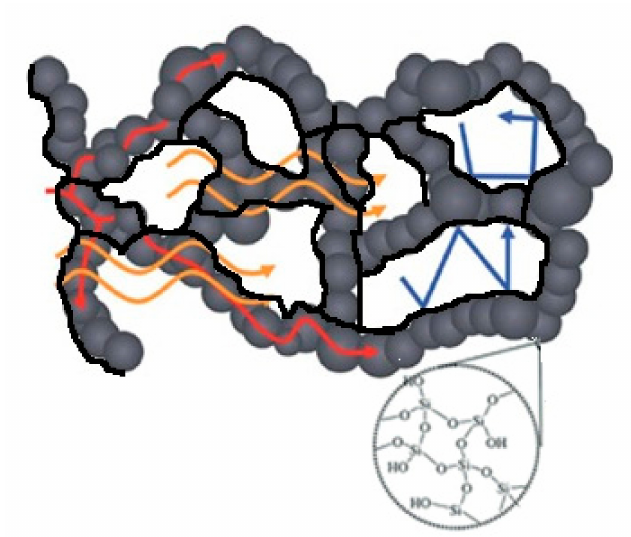
Figure 1. Di ff erent forms of heat propagation in the fiber-reinforced aerogel (nanoporous material). Red is the solid conduction, yellow is the radiative part and blue is the conduction of gas molecules. Black is the glass